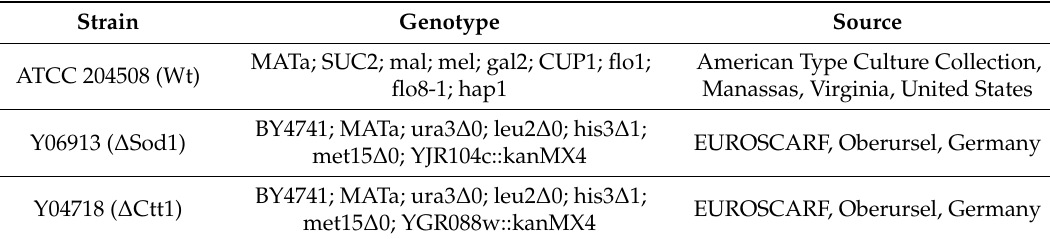
Table 1. Saccharomyces cerevisiae strains used in the